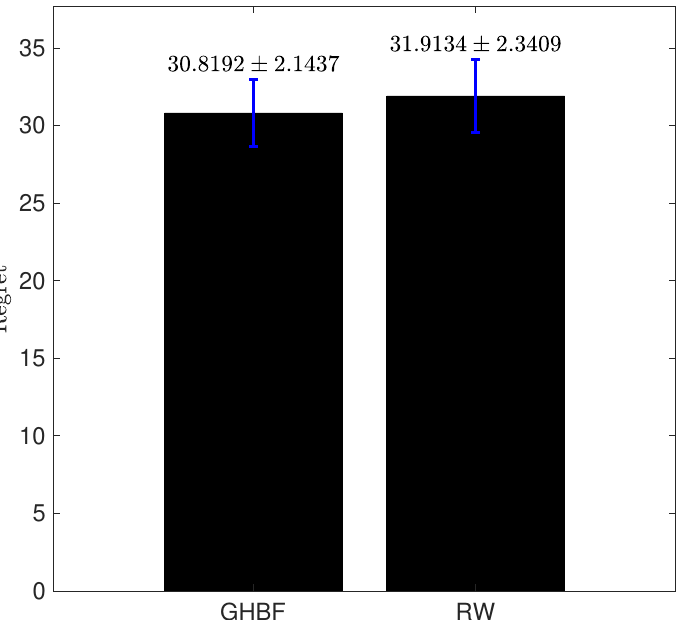
Figure 10. The statistic mean ¯ R i and standard deviation σ R